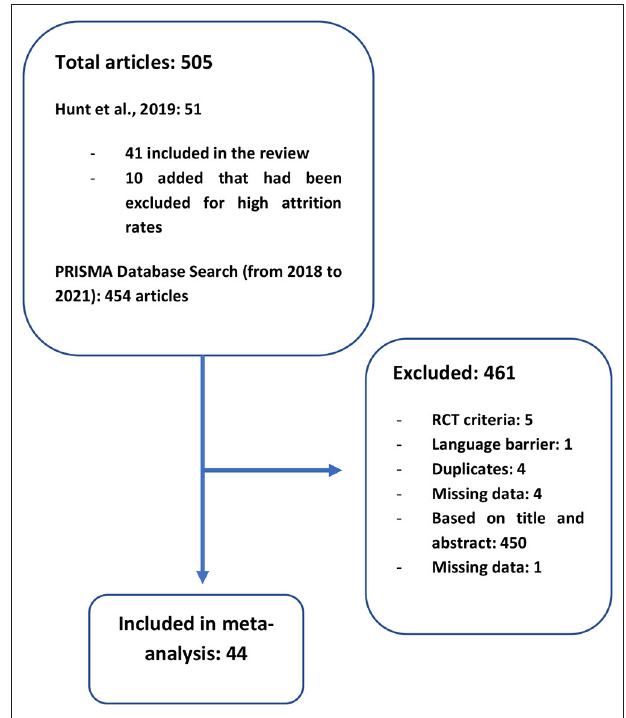
FIGURE 1 | Flow diagram: articles selection